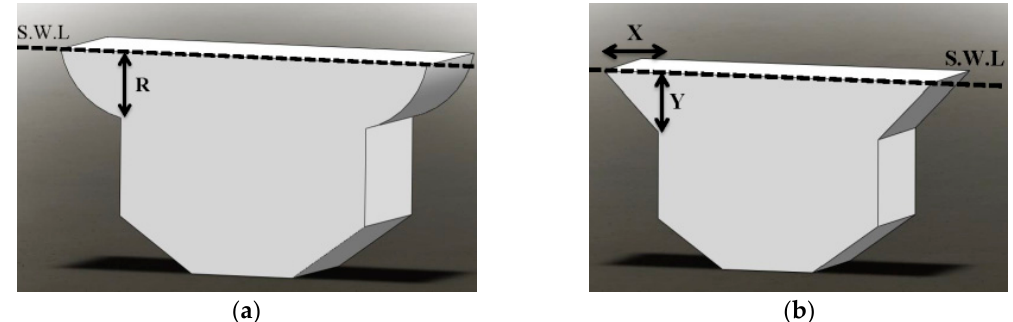
Figure 19. Description of ( a ) the upside filleted shape, and ( b ) the upside chamfered shape. For these geometries, the parameter R in the upside filleted shape, and the parameter Y in the upside chamfered shape are varied between 0.1 to 2m. The results from the optimization of these figures are shown in Figure 20.